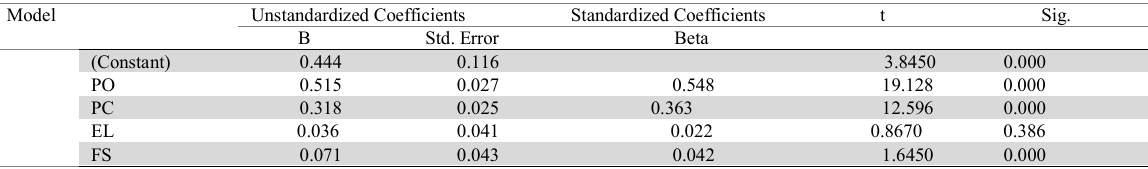
Table 8 (Coefficients) represents the coefficients for the regression equation, which is: Entrepreneurial intention = 0.444 + 0.515× perceived opportunities + 0. 318× perceived capacities +0.071 × field of study + 0.036× educational